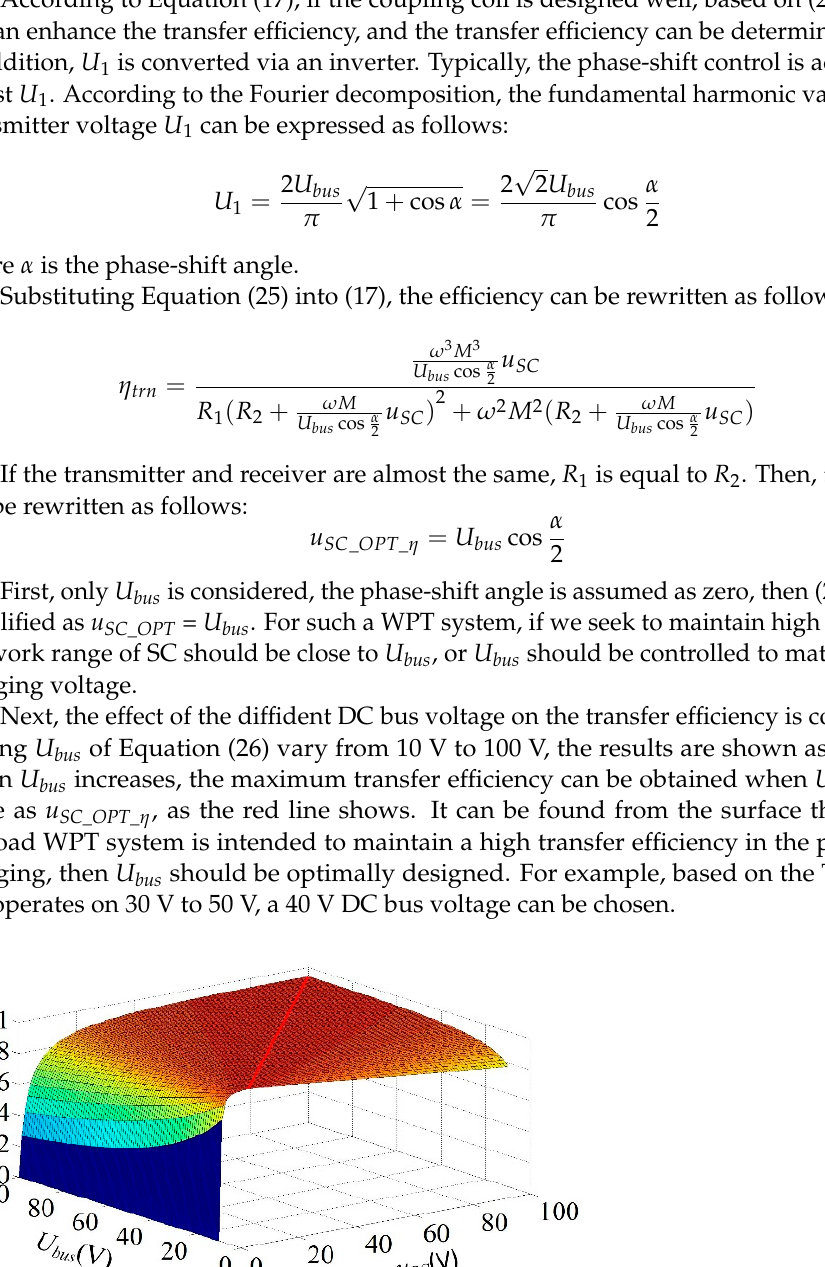
Figure 8. Transfer efficiency vs. α and u SC . The transmitter voltage is decided by both the DC bus voltage and the phase-shift angle, and these two factors further affect the transfer efficiency. 3.3. Effects of Frequency Offset on WPT System In practical applications of the WPT system, the value of the compensation capacitor cannot be selected continuously, and the operating frequency may need to be adjusted to achieve the soft-switching of the inverter. Therefore, it is possible to cause the operating frequency to deviate from the resonant frequency, so it is necessary to analyze the effects of frequency offset on the SC-load WPT system.